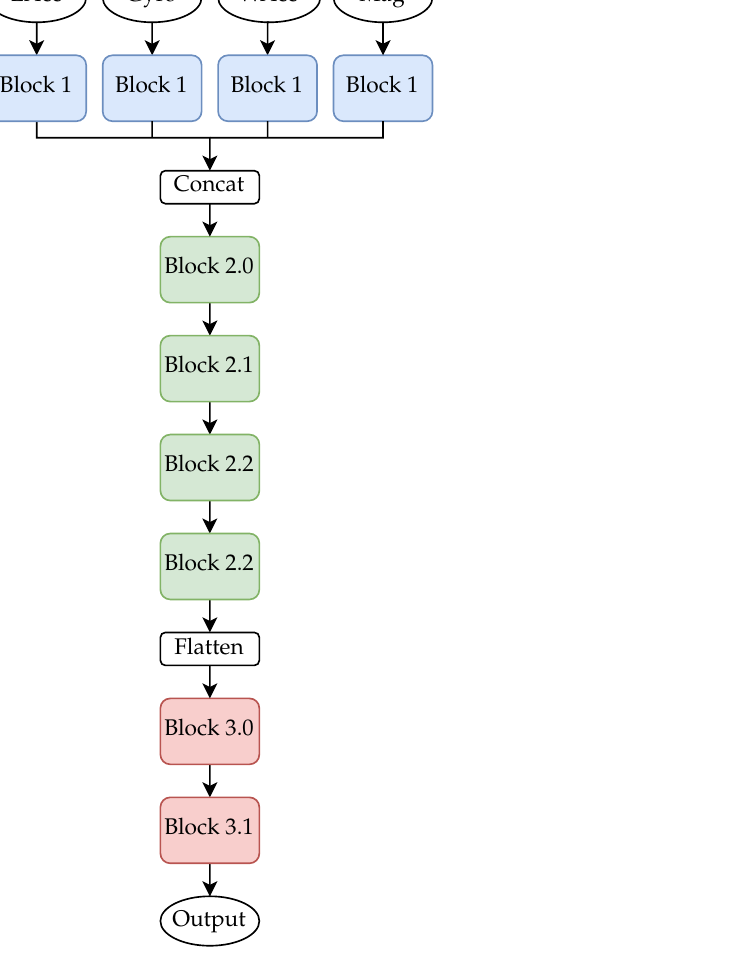
Figure 1. The deep neural network used for this research. Each sensor modality had its own input. The inner structure of the blocks are shown in Figure 2.